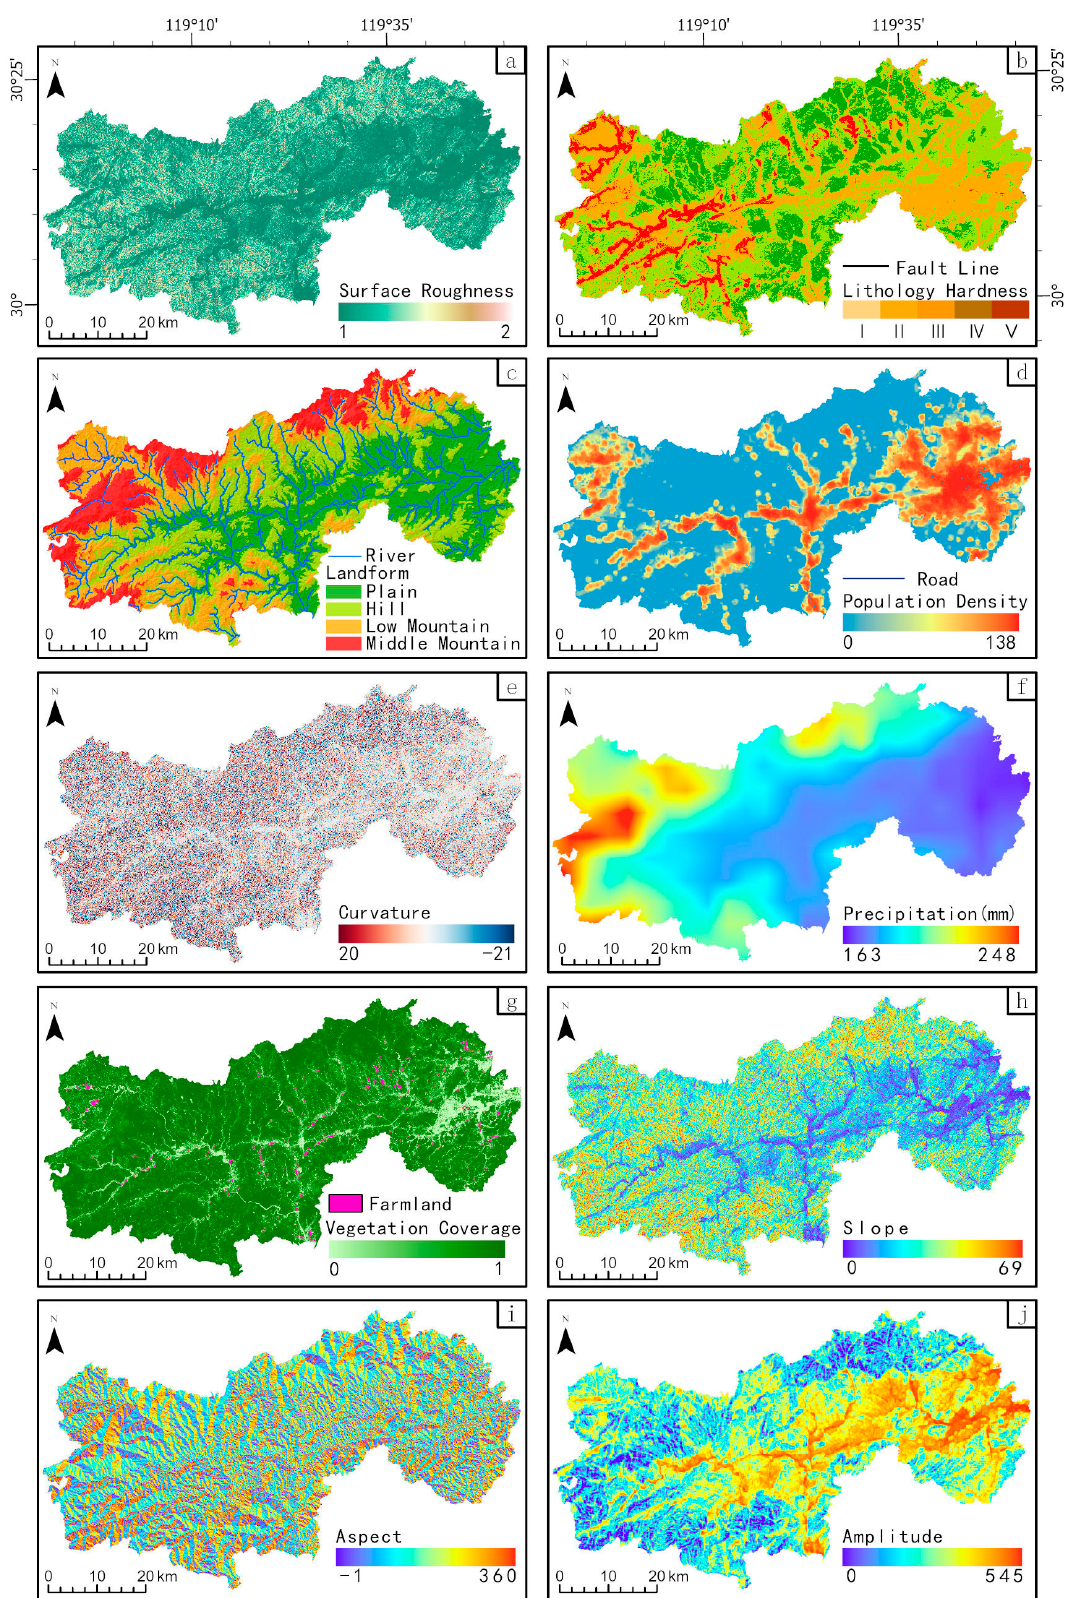
Figure 2. The spatial patterns of some landslide conditioning factors. ( a ): surface roughness; ( b ): lithology and fault lines; ( c ): landforms and rivers; ( d ): population density (persons/km 2 ) and road; ( e ): curvature; ( f ): precipitation (mm); ( g ): vegetation coverage; ( h ): slope; ( i ): aspect; ( j ): relief amplitude.